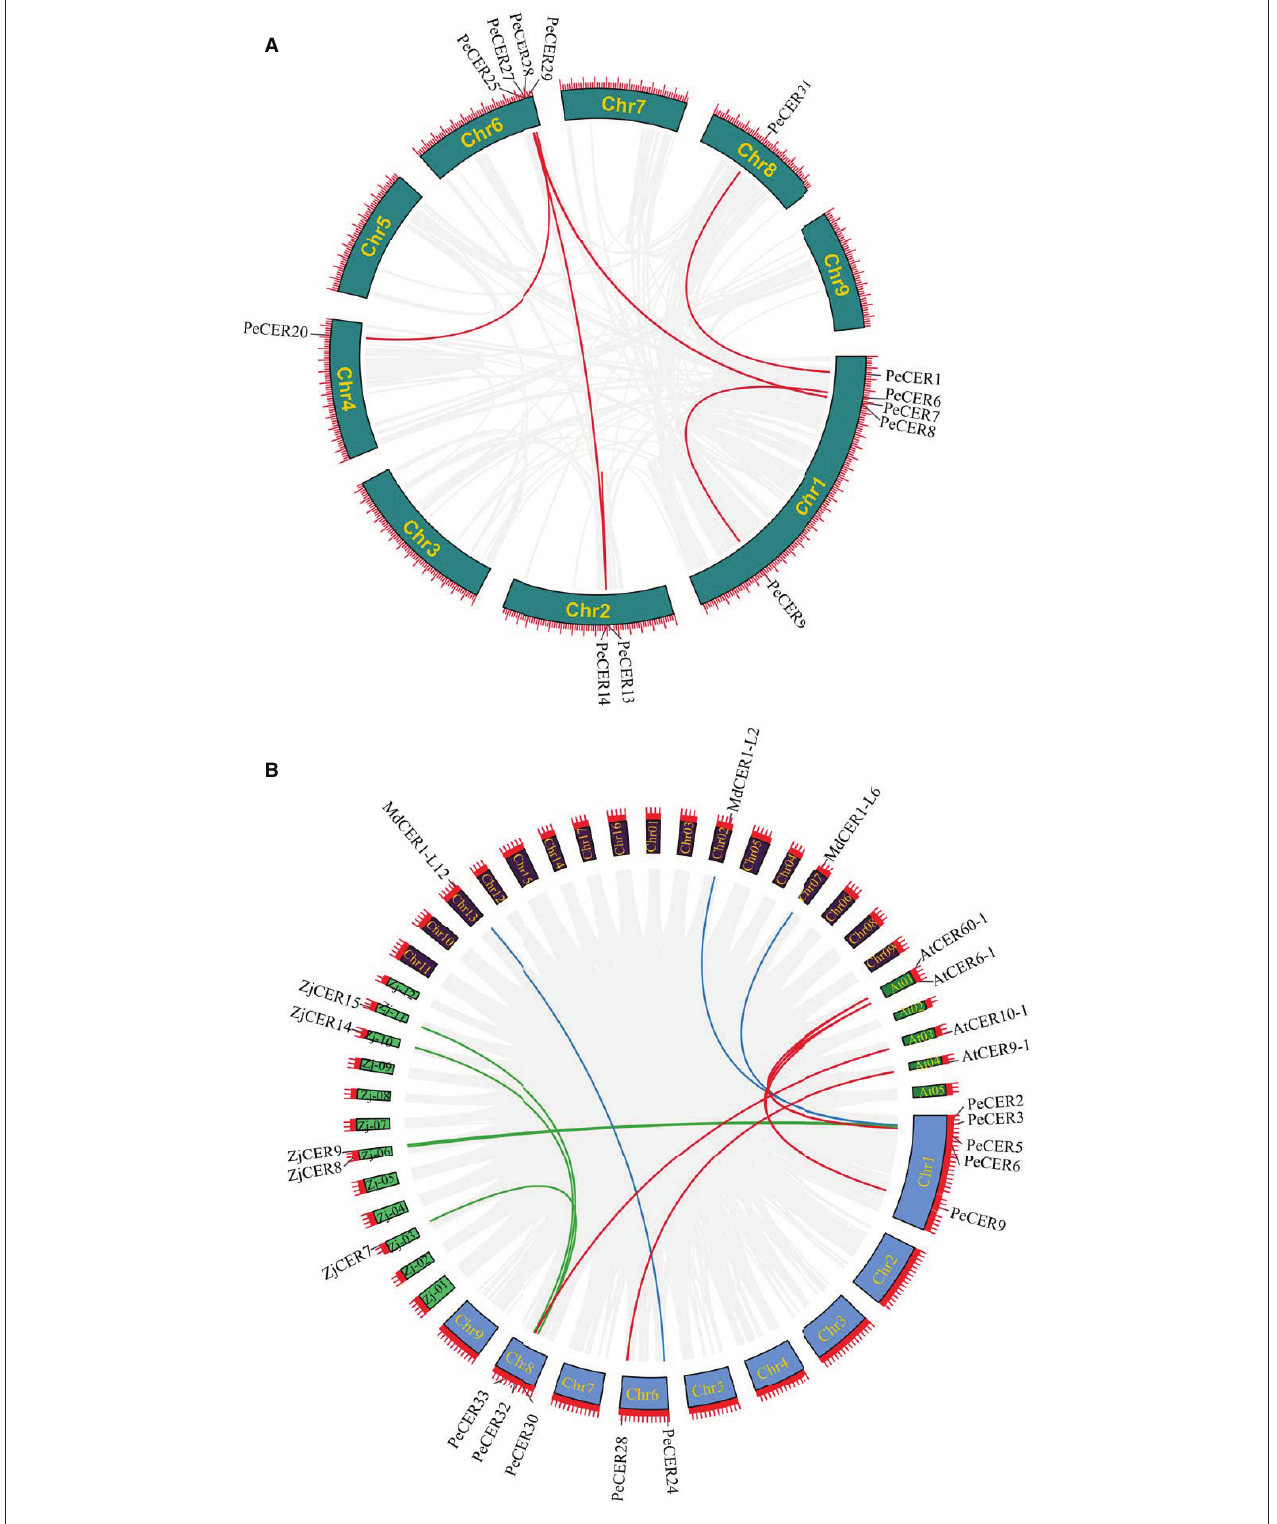
FIGURE 3 | Circos illustrations of PeCER gene duplication. (A) Gene duplication of CER genes in P. edulis . The background gray lines show all the syntenic blocks in the passion fruit genome, and the red lines show segmental or tandem duplication link regions among the PeCER genes. The approximate location of PeCER genes were labeled with a short gray line outside with gene names. (B) Orthologous of P. edulis CER genes with A. thaliana , M. domestica , and Z. jujuba CER genes.